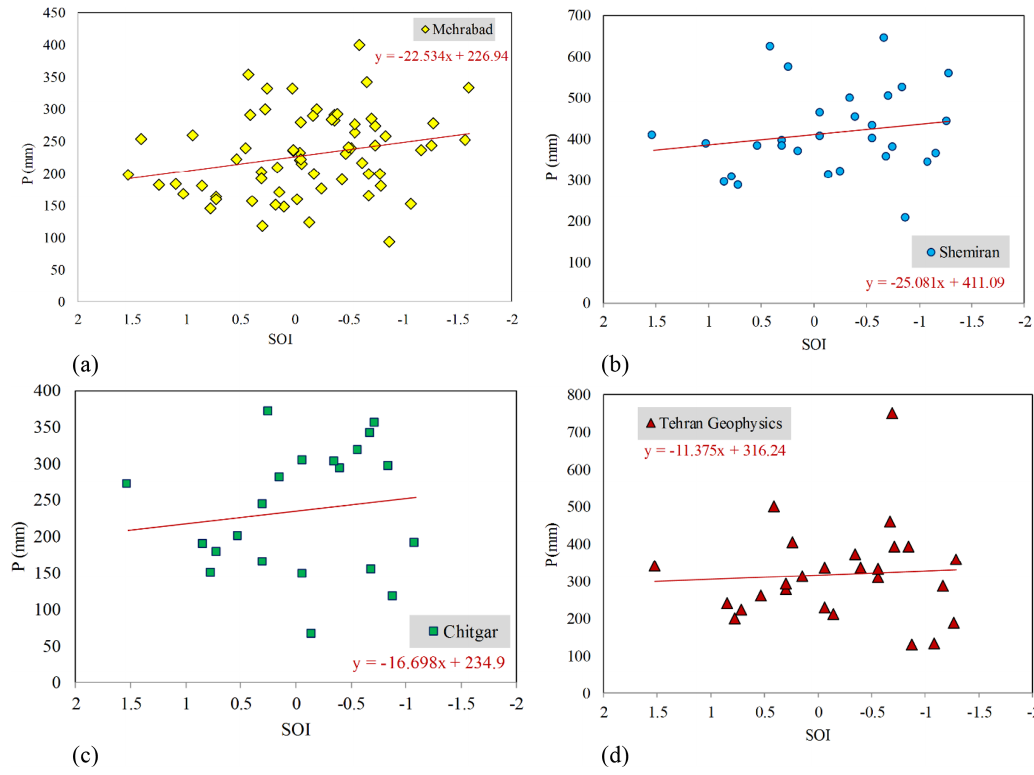
Figure 3. Annual rainfall against SOI index at the stations of (a) Mehrabad, (b) Shemiran, (c) Chitgar, and (d) Tehran